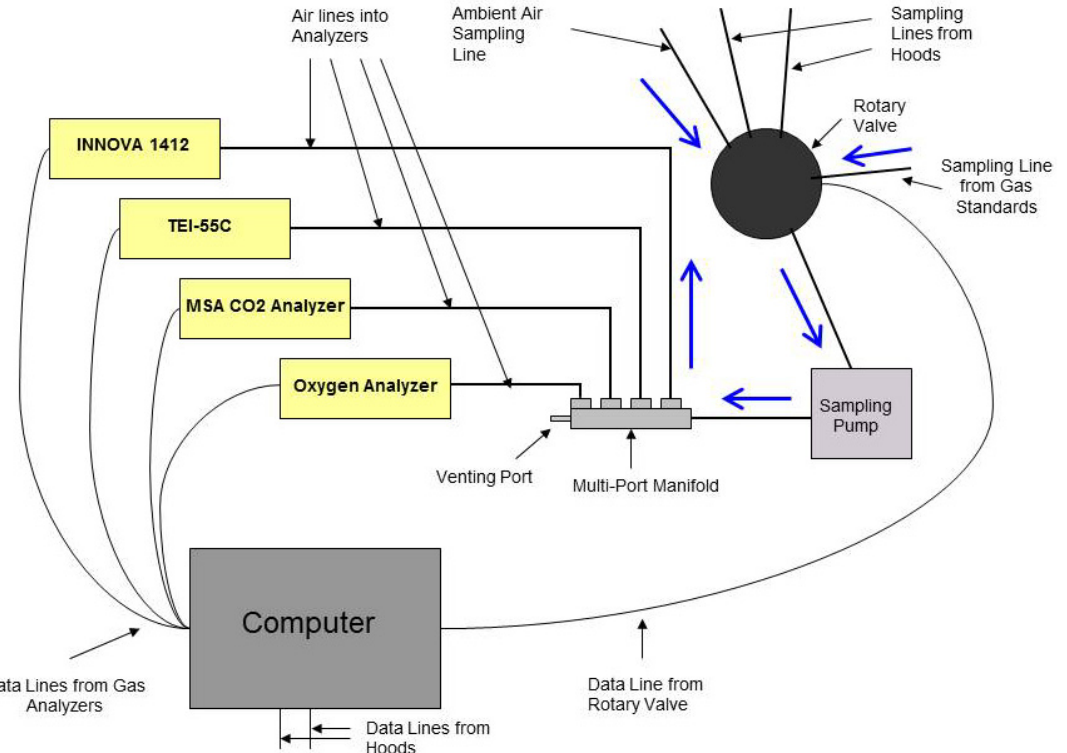
Figure 2. A schematic overview of the set-up inside the instrumentation cabinet. Blue arrows indicate the air flow